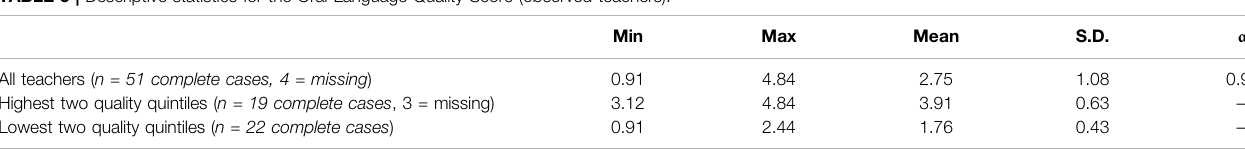
TABLE 5 | Descriptive statistics for the Oral Language Quality Score (observed